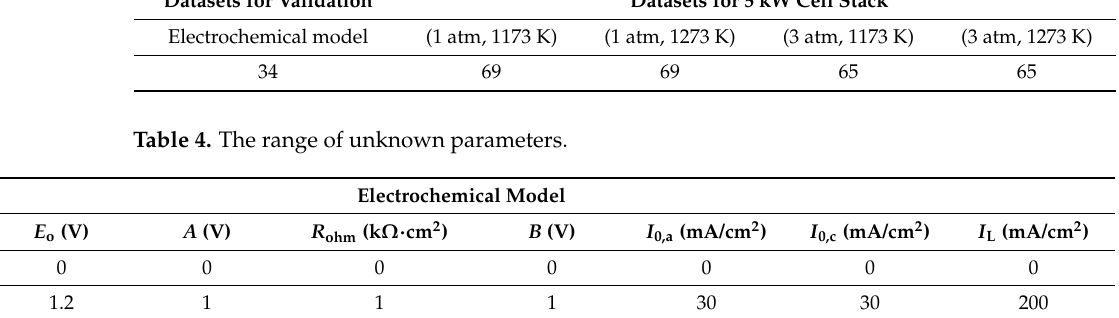
Figure 12. Datasets for 5kW cell stack under various operating scenarios.